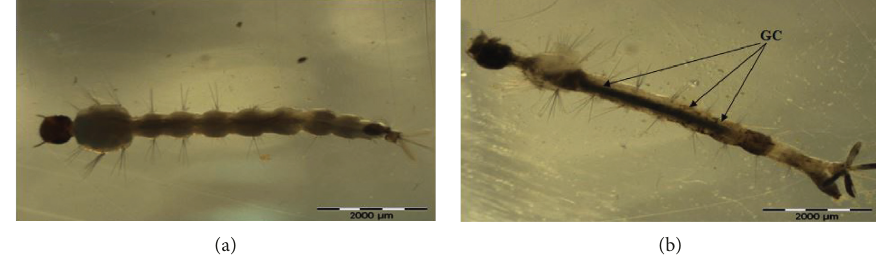
Figure 2: Morphological midgut content induced by Azolla pinnata plant extract from acetone and methanol solvent extractions in late 3rd instar Aedes albopictus larvae. (a) Control test for midgut content. (b) A. pinnata crude extract for midgut content in larvae. Note: arrows indicate the plant extracts (dark colour); GC: gut content (after 24 hours).